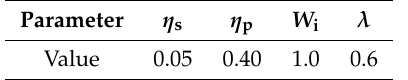
Table 4. Parameters used in simulations.